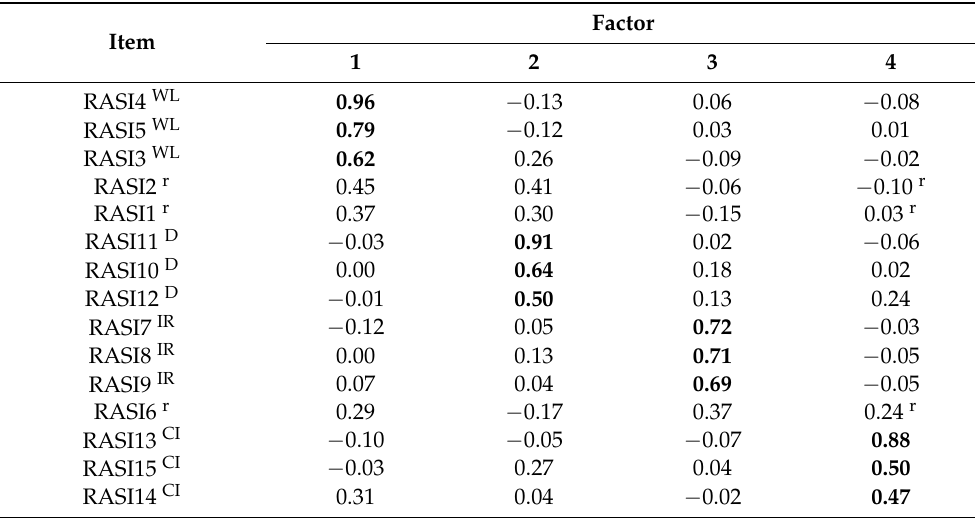
Table 3. EFA item loadings for 15-item the Riverside Acculturation Stress